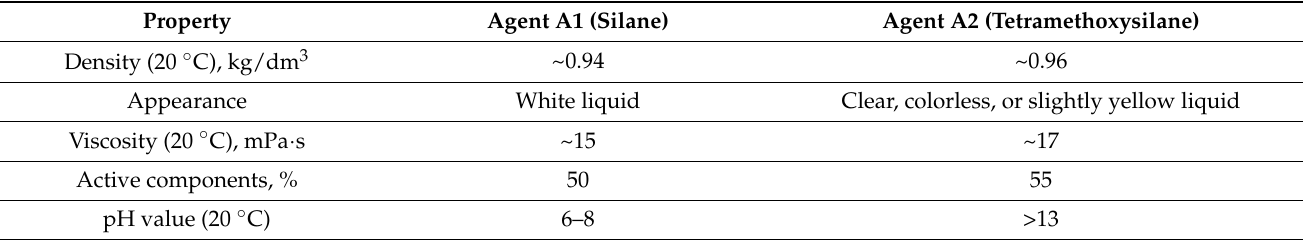
Table 1. The basic characteristics of hydrophobizing agents.